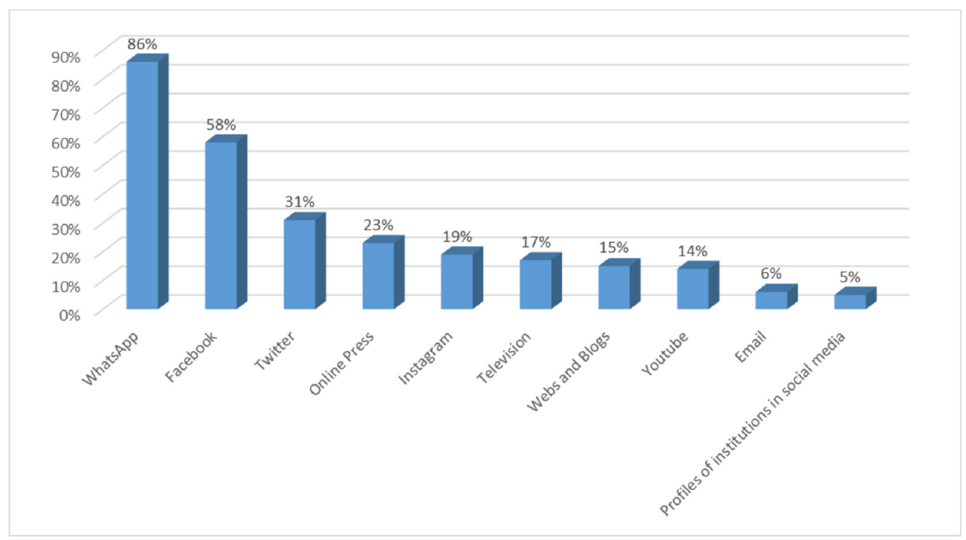
Figure 4. Main ways which citizens receive false news.